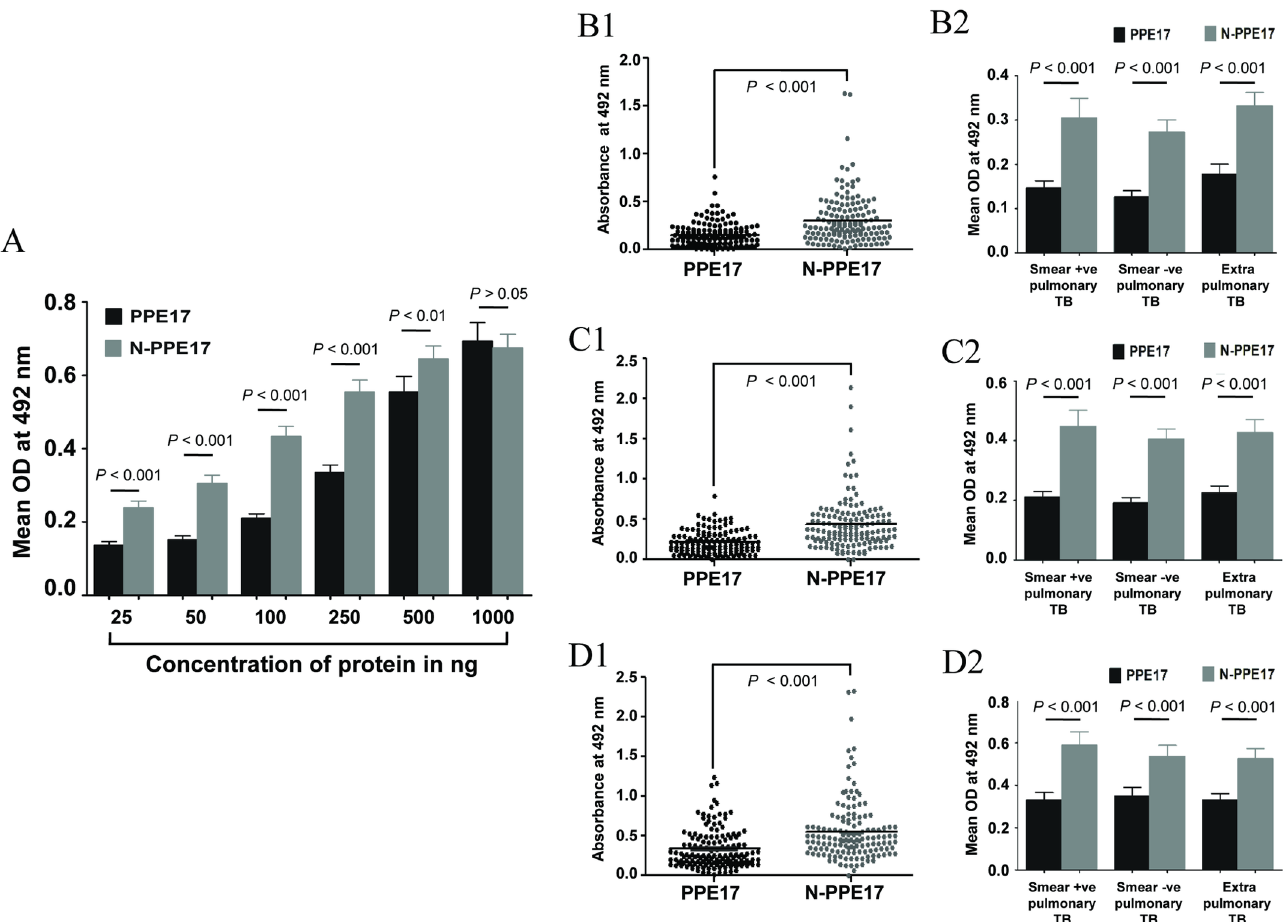
Fig 4. The N-terminal fragment of PPE17 (N-PPE17) shows better seroreactivity than full-length PPE17 in active TB patients (n = 143). (A) The full-lengthPPE17 or N-PPE17 protein was coated on EIA plate at variousconcentrations starting from 25 ng/well/50 μ l to 1 μ g/well/50 μ l and antibody responses of TB patient sera were compared. The negativecontrol (no antigen)displayeda background absorbancevalue of 0.056. Data shown in Fig 4A were re-plottedto comparethe antibody levels of TB patients betweenPPE17 and N-PPE17 at 50 ng/well/50 μ l (B1), 100 ng/well/50 μ l (C1) and 250 ng/well/50 μ l (D1) antigencoating concentrations. Data from Fig 4A were re-plottedto comparethe PPE17 and N-PPE17-specific antibody levels in sera samples of smear positive (n = 58), smear negative(n = 38) and extrapulmonary TB (n = 47) patients at antigenconcentration